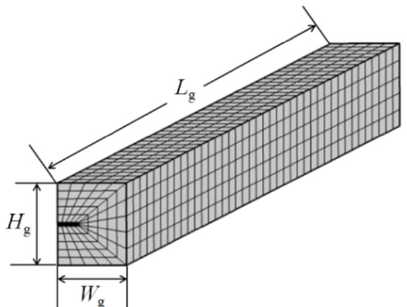
Figure 2. FEM model and mesh dividing of optical fiber coated by glue.